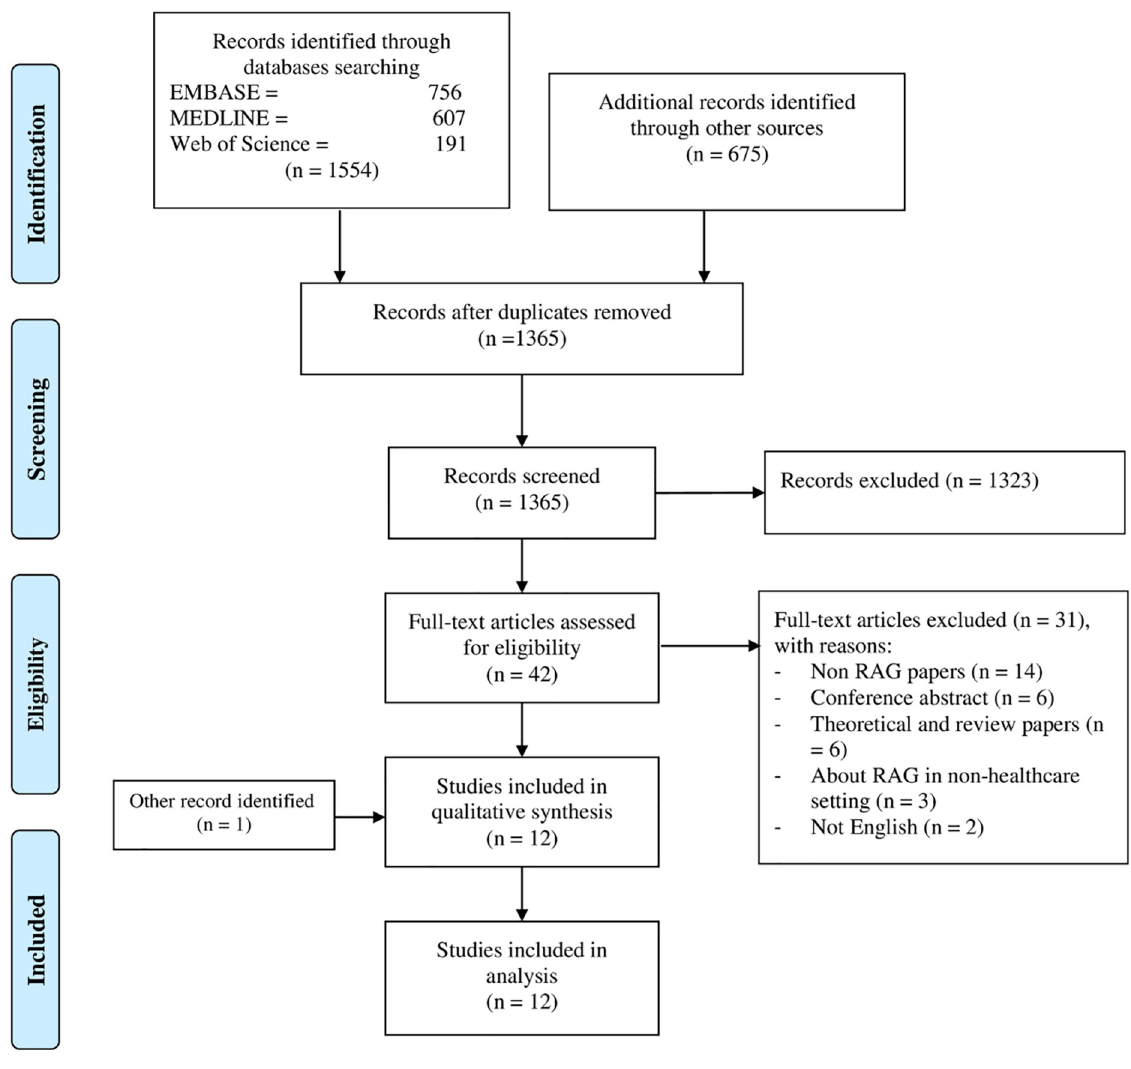
Fig 1. PRISMA flow